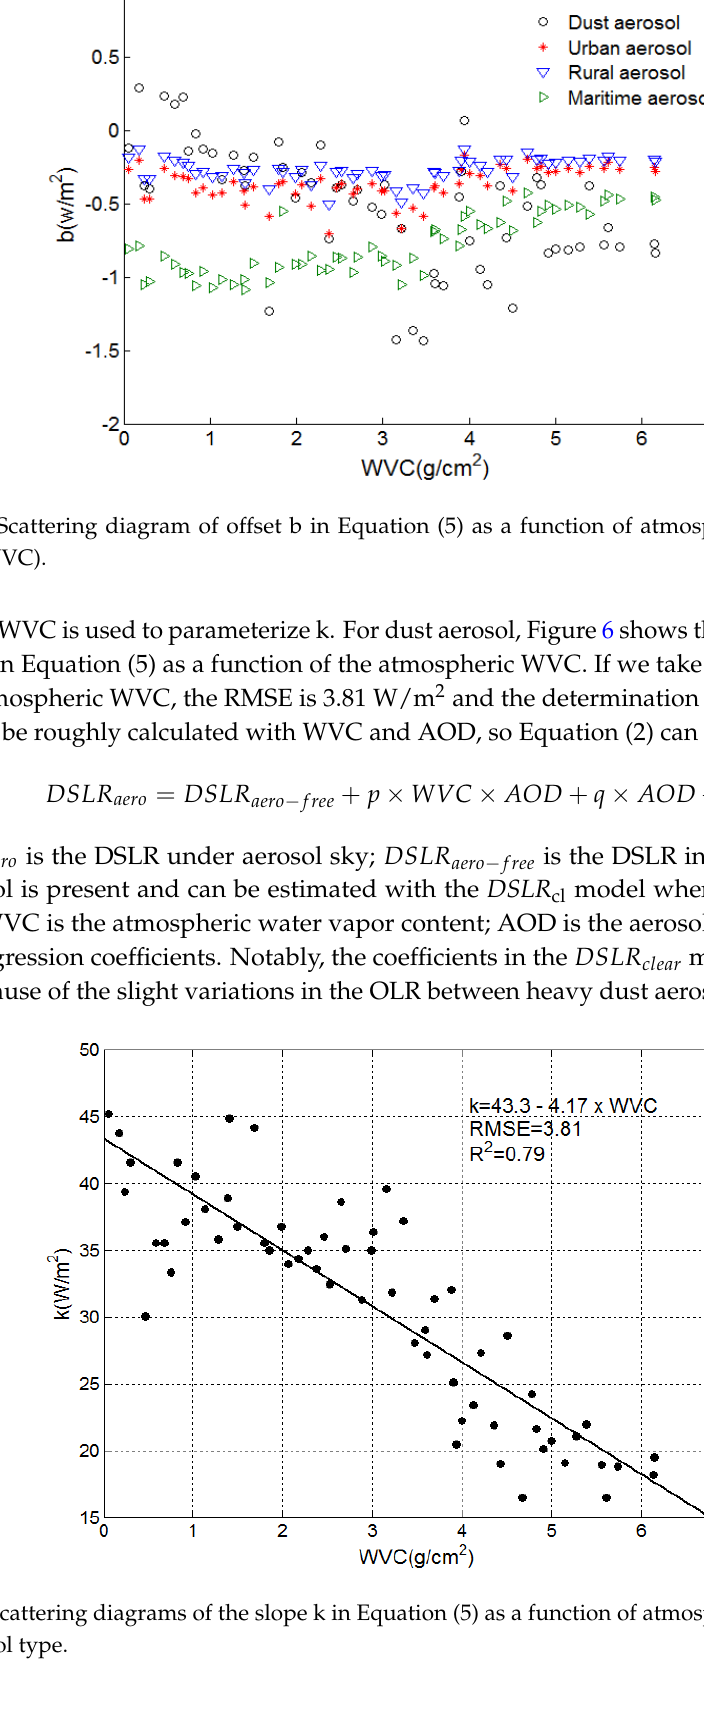
Figure 4. Comparing with the clear sky, the rate variations of top of the atmosphere (TOA) channel radiance at different aerosol conditions as the AOD increase. The symbols indicate the rate variations of channel radiance and the half-length of vertical bars represent the Standard Deviations of the rate variations of TOA channel radiance.